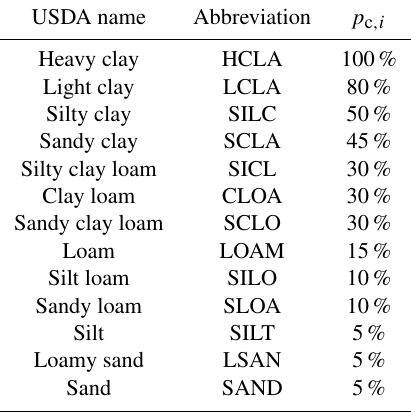
Table 3. Clay content assumed for the USDA soil